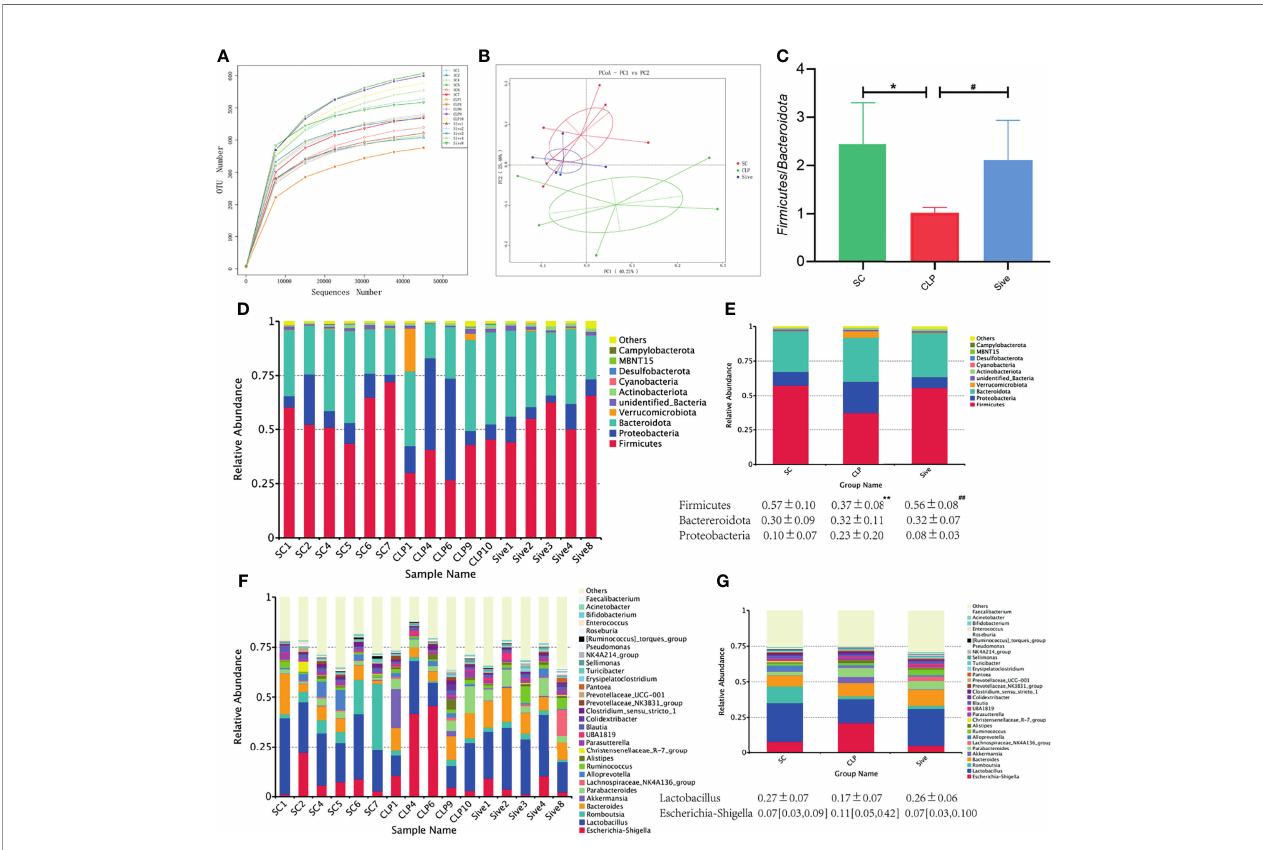
FIGURE 1 | Effects of Sivelestat on gut microbiome diversity and structure. (A) Rarefaction Curve of samples showing the appropriateness of sequencing depth. (B) PCoA plot based on weighted unifrac distance of OTUs (97% similarity level). (C) The Firmicutes / Bacteroidetes ratios of the experimental groups. (D, E) Relative bacterial distribution at the phylum level. (F, G) Relative bacterial distribution at the genus level. * Compared with the SC group; # compared with the CLP group; * , # P <0.05; ** , ## P total ion fl ow patterns of the experimental groups are shown in Supplementary Figure 3 . The peak type of the CLP group was signi fi cantly different than that of the SC group, whereas the SC and Sive groups had similar peak types. Principal component